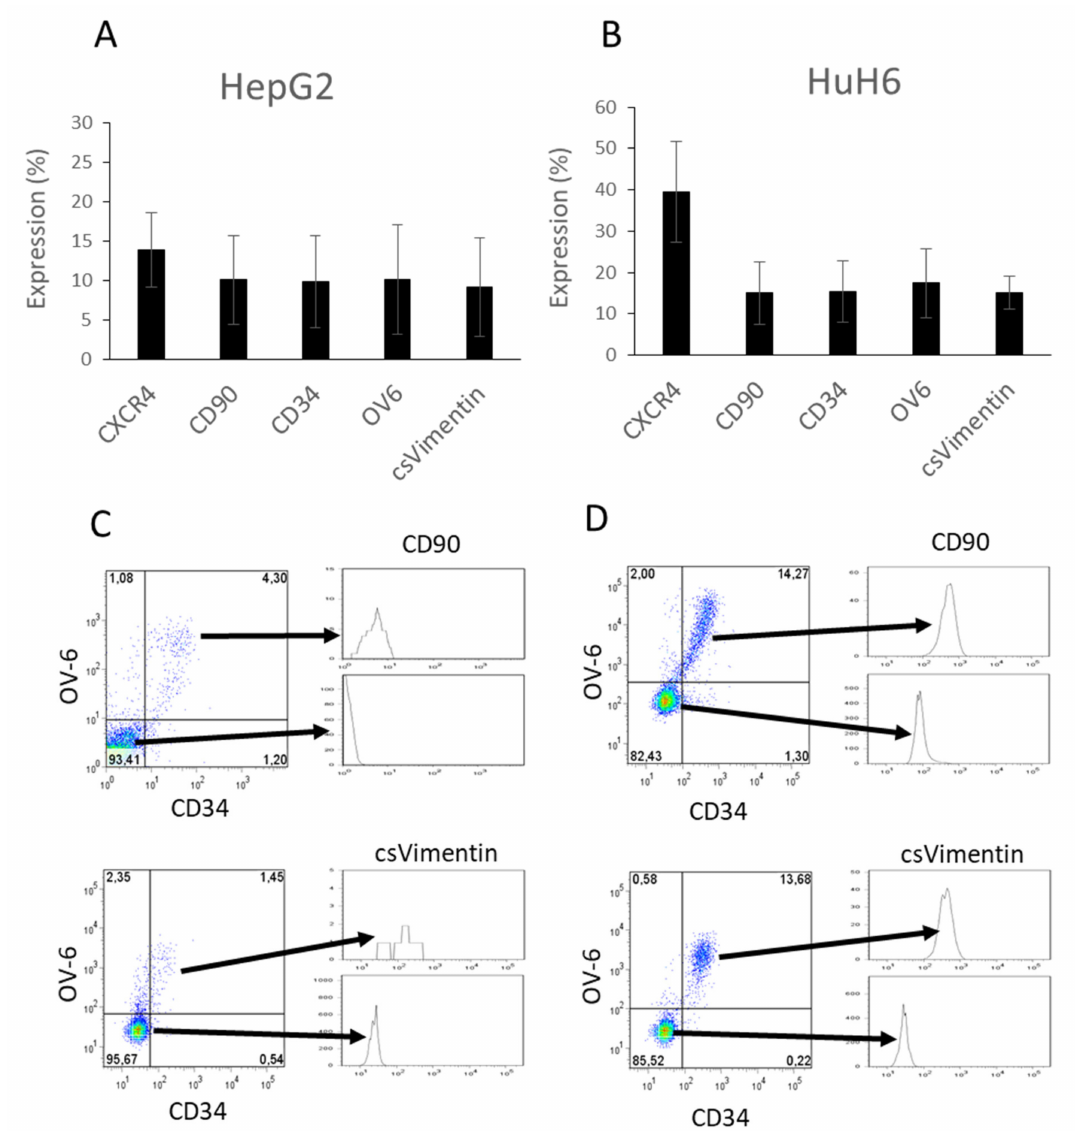
Figure 1. CD34, CD90 and csVimentin expressions and OV-6 binding were detected on a subpopulation of HepG2 and HuH6 cells. ( A ) The expressions of CXCR4, CD90, CD34 and vimentin and the binding of OV-6 on HepG2 cells and ( B ) on HuH6 cells were measured using flow cytometry. The box plots show the mean of at least 10 independent measurements with error bars depicting the standard deviation from the mean. ( C ) HepG2 and ( D ) HuH6 cells were simultaneously stained with α -CD34, OV-6 and α -CD90 antibodies and with α -CD34, OV-6 and α -vimentin antibodies, respectively. The cells were gated for CD34 and OV-6 double-positive and CD34 and OV-6 double-negative cells and subsequently analyzed for CD90 or csVimentin expression. These are representative results of at least 10